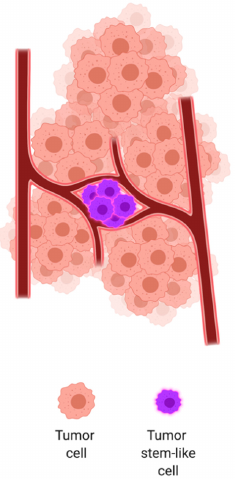
Figure 1. The tumoral stem cell perivascular niche. Tumor stem-like cells are commonly found in the perivascular space. Although we still do not fully know the reasons why, the causes are usually attributed to metabolic needs and dependency on molecular signals coming from tumor endothelial cells.